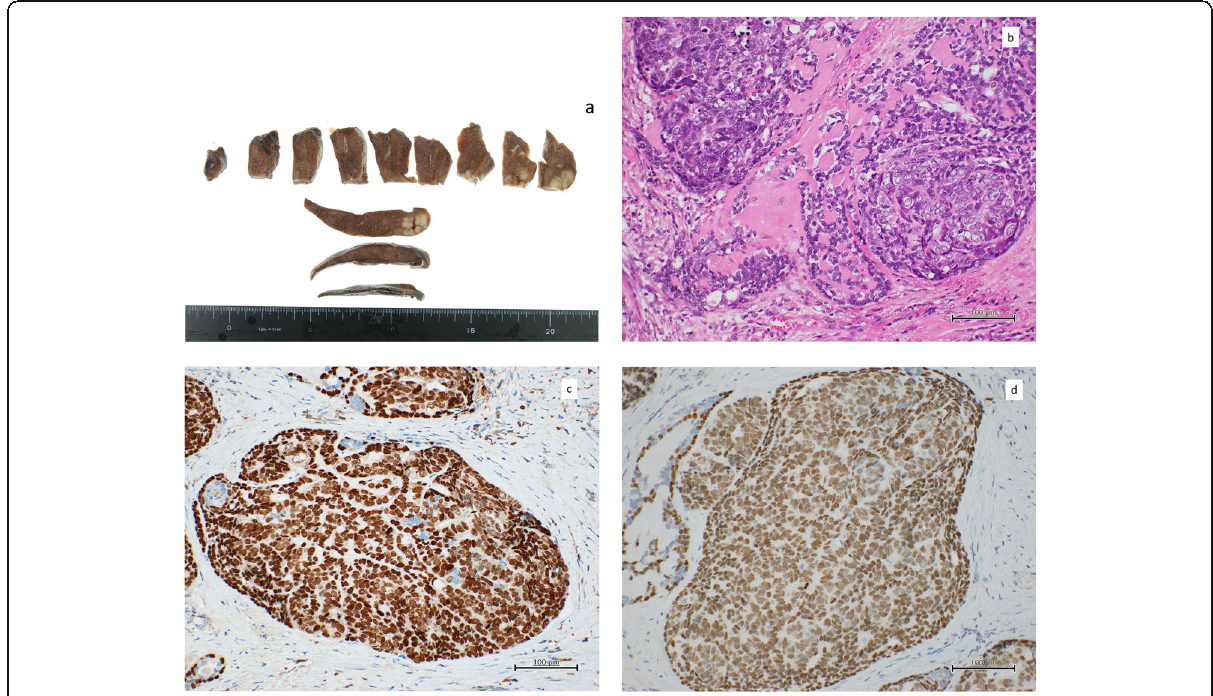
Fig. 3 a Macroscopic observation of the resected left lung specimen shows a white nodule with irregular borders. b Histological evaluation of the pulmonary lesion, leading to diagnosis of metastasis of basaloid squamous cell carcinoma of the esophagus with deposition of hyaline-like material (hematoxylin and eosin stain, × 100). Immunohistochemical examinations show that the metastatic tumor cells are positive for c p63